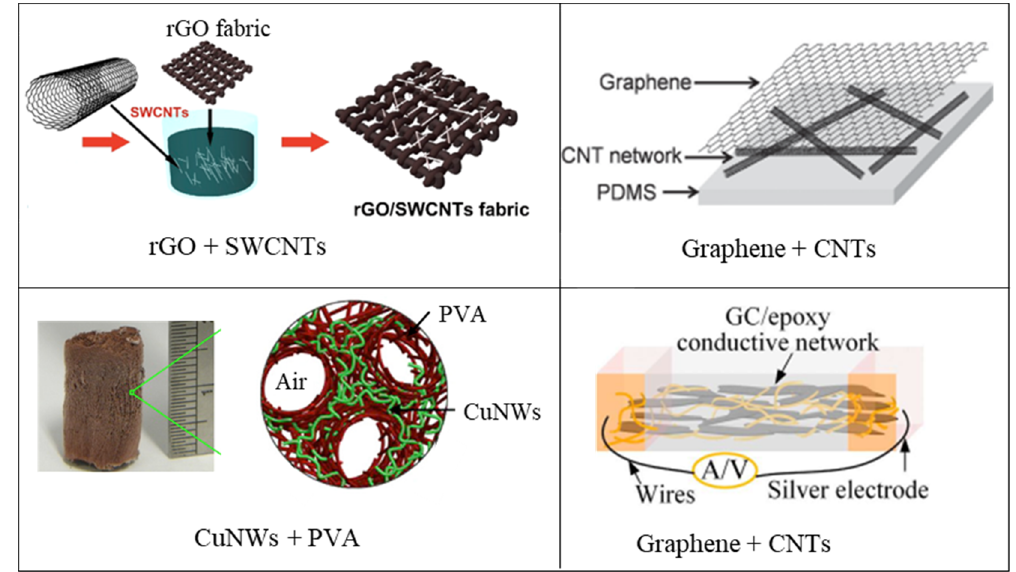
Figure 7. Hybrid conductive materials.